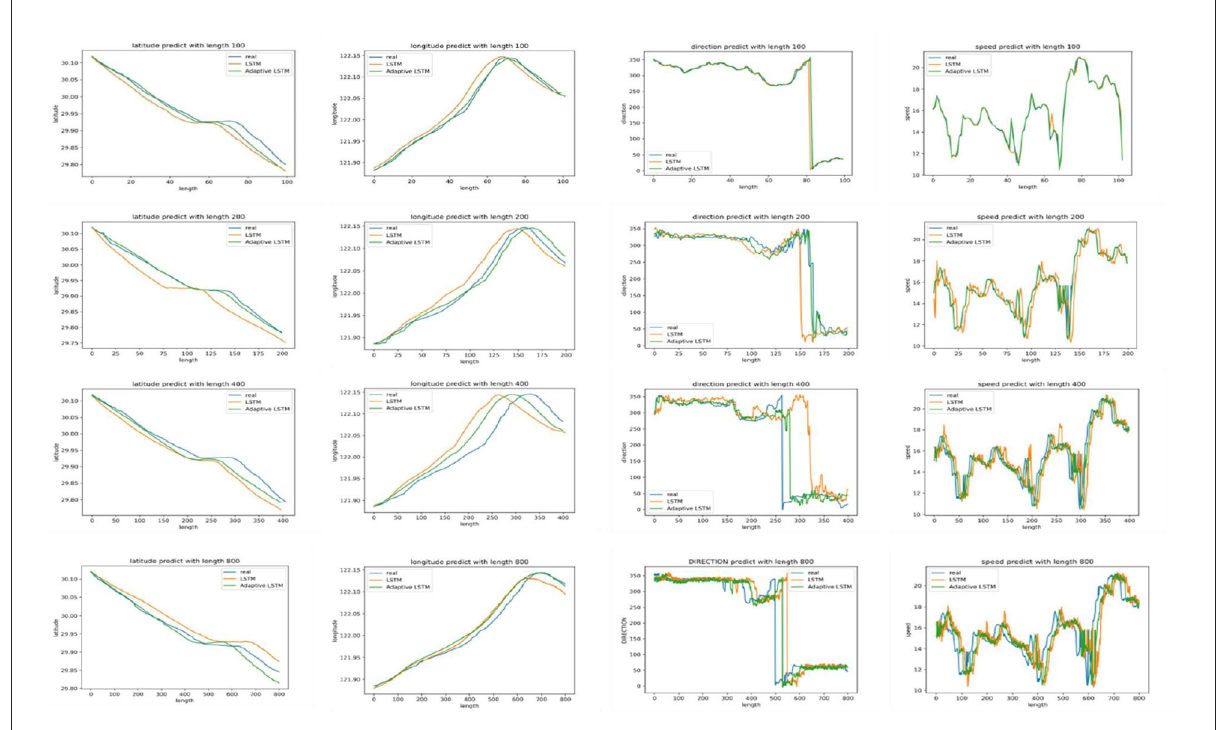
FIGURE9 Prediction of route data with different lengths.